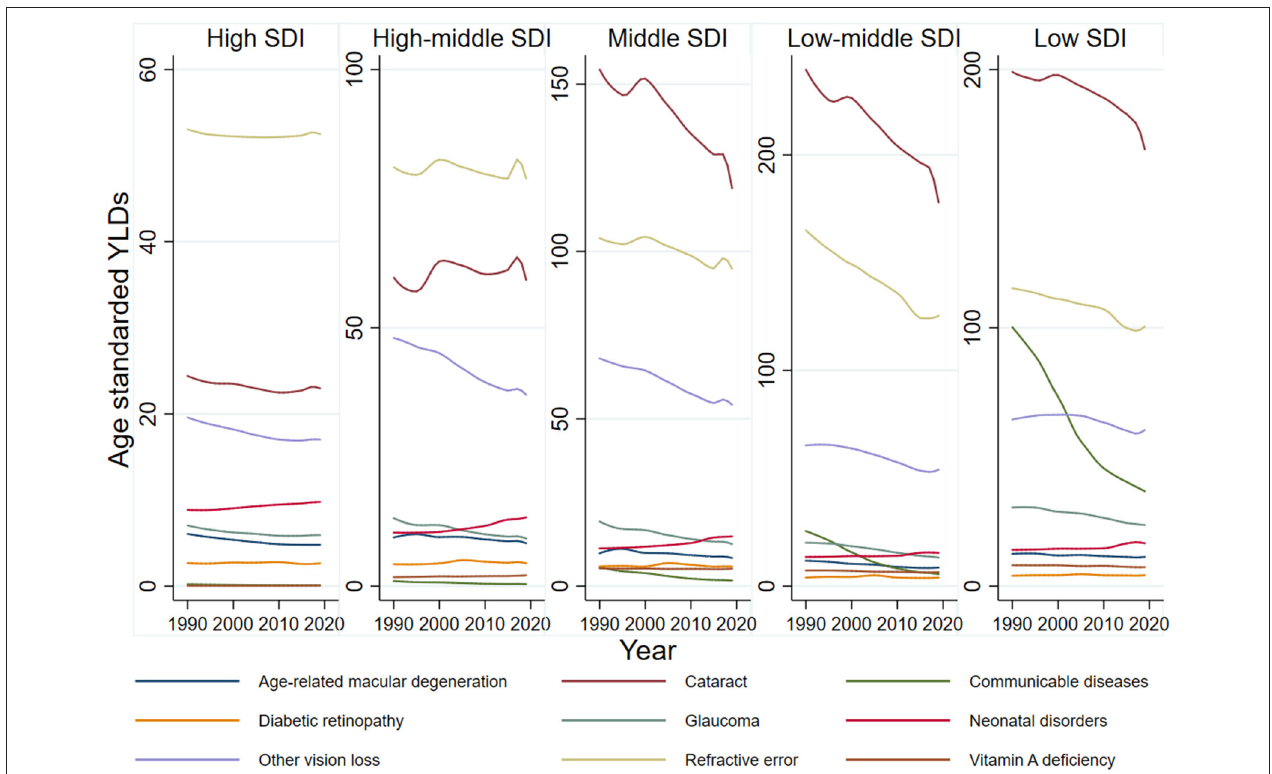
FIGURE 1 | Age-standardized, cause-specific YLD rate of blindness and distance vision impairment by Socio-Demographic Index groups,